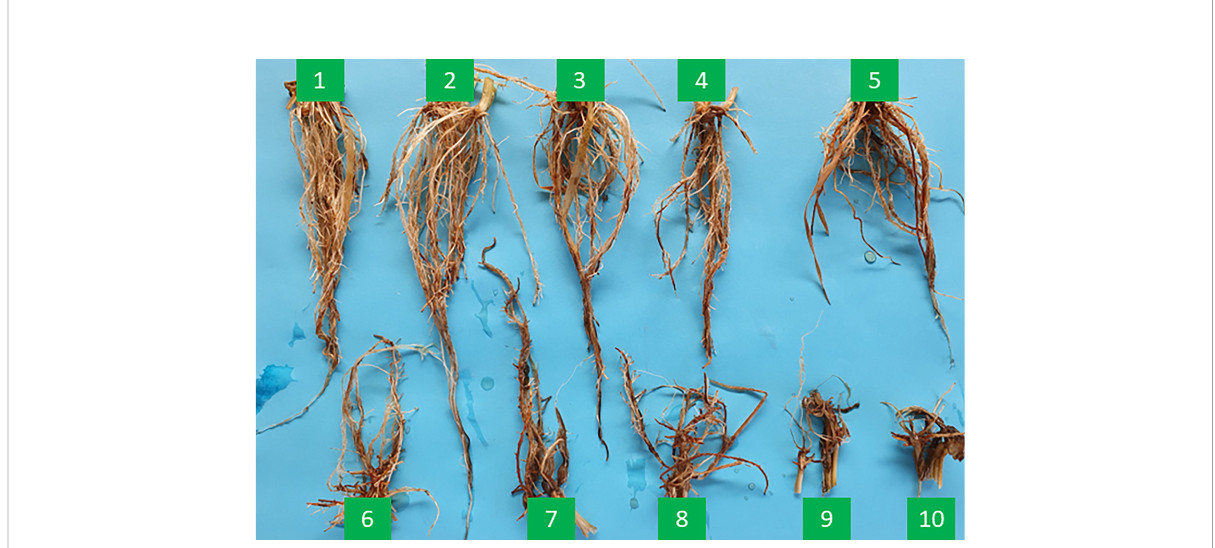
FIGURE 1 Root damage scores under waterlogging conditions. Damage score of 1: highly tolerant; damage score of 10: severely damaged with no survived